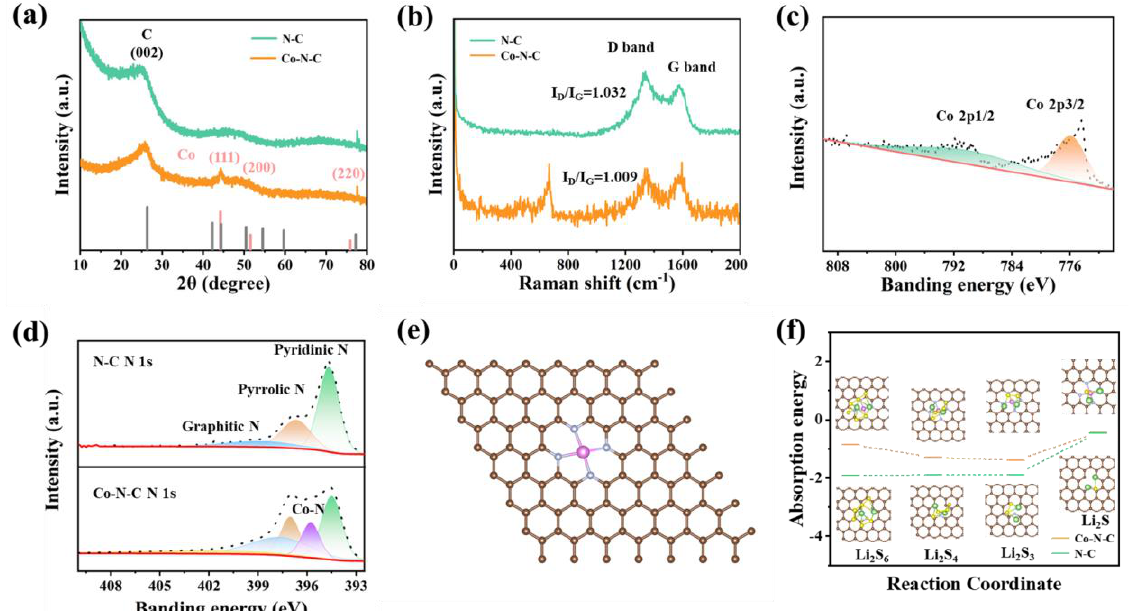
Figure 2. Structural characterization ( a ) XRD patterns of Co−N−C and N−C membrane. ( b ) Raman spectra of Co−N−C and N−C membrane. ( c , d ) High−resolution XPS spectra of N 1s and Co 2p for Co−N−C and N−C membrane. ( e ) The optimized configurations of Co−N−C. ( f ) Density functional theory (DFT) calculation of absorption energy between Co−N−C/N−C and Li 2 S 6 /Li 2 S 4 /Li 2 S 2 /Li 2 S.